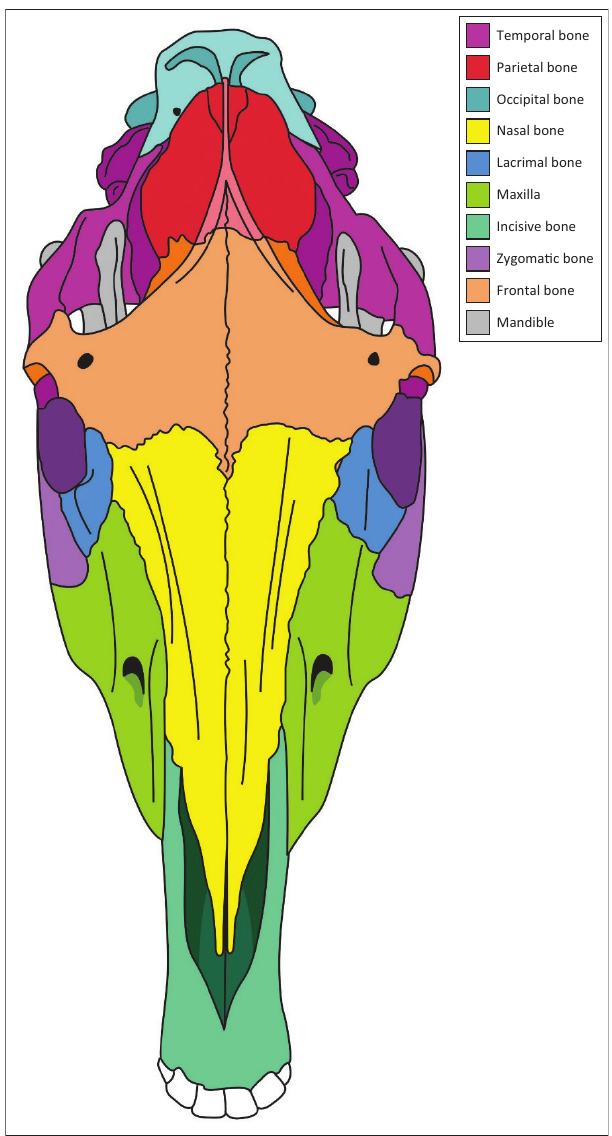
FIGURE 2: A diagram of the equine cranium from the dorsal perspective illustrating the craniofacial suture